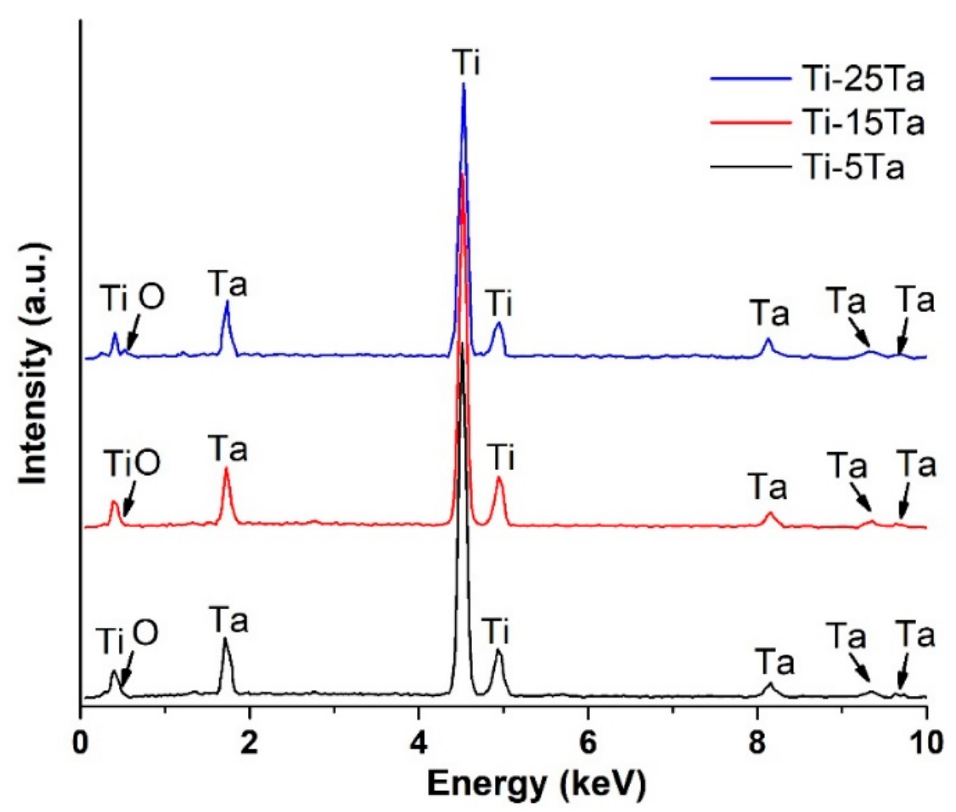
Figure 3. EDS spectra of the investigated